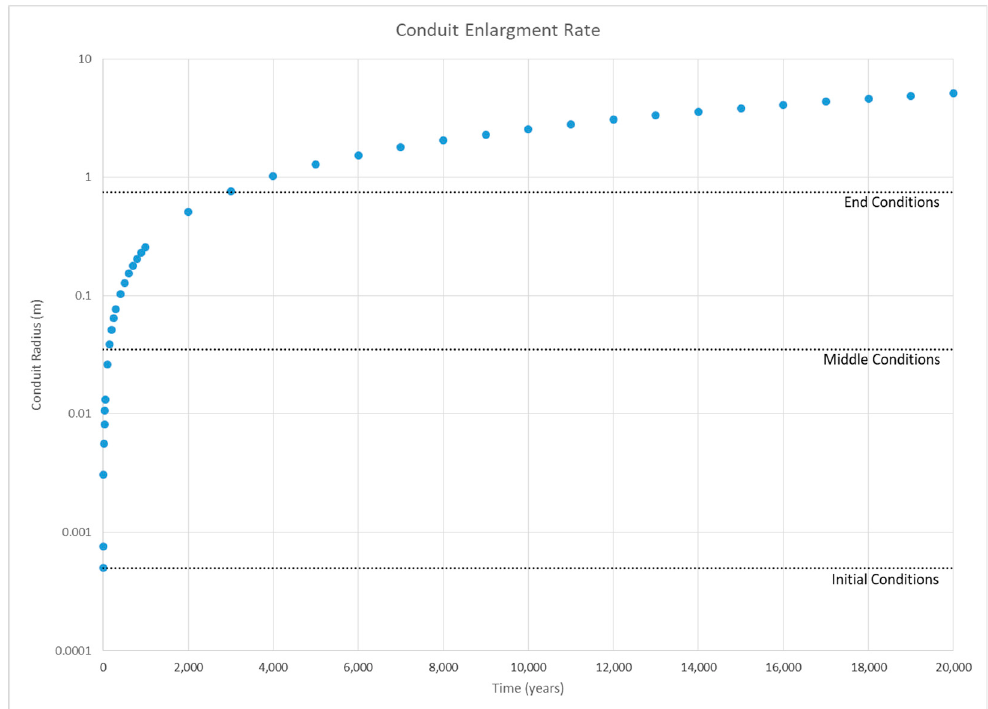
Figure 10. Conduit growth rates based on Moore et al. [29] along with the discrete porosity sizes indicated. The middle conditions are touching-vug porosity, and the end conditions are conduit flow. The time spent at a stable lowstand through the Pleistocene is about 10,000 years, sufficient enough time to at least theoretically allow for the formation of large conduit caves. Additionally, several sea-level lowstands were repeatedly experienced during the Pleistocene allowing for re-activation of old conduits and continued dissolution.